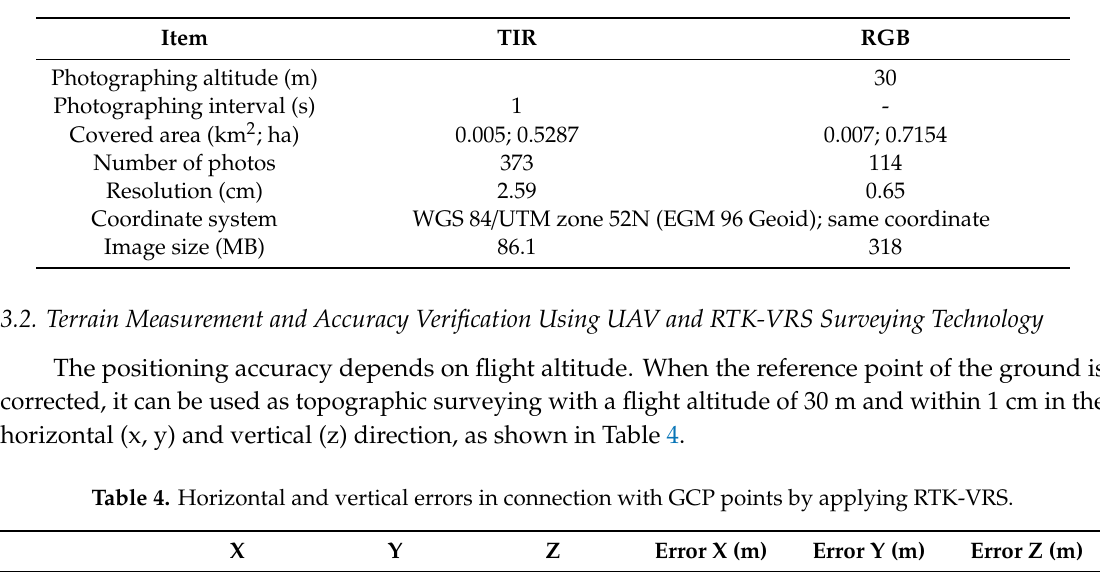
Table 3. Condition acquired by mounting optical sensor and thermal infrared sensor.